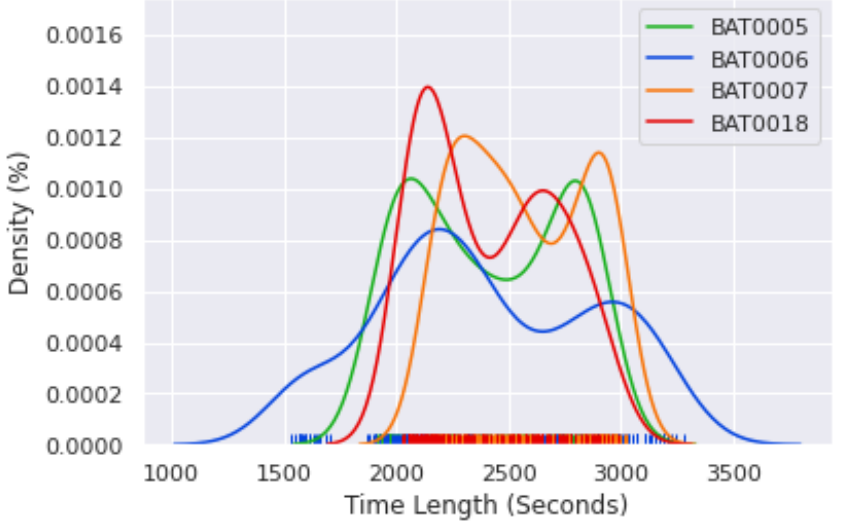
Figure 9. Time length distribution comparison of prediction over all